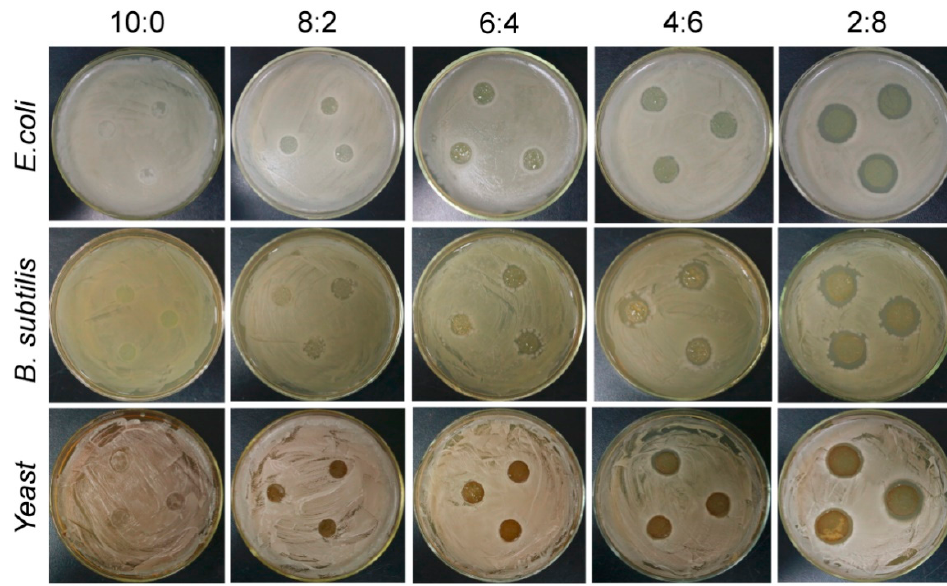
Figure 7. Antimicrobial activities of the composite films with different St/PL mass ratios with two bacteria and a fungus. Table 1. Diameter of the antimicrobial zones on the films exposed to three microbes.